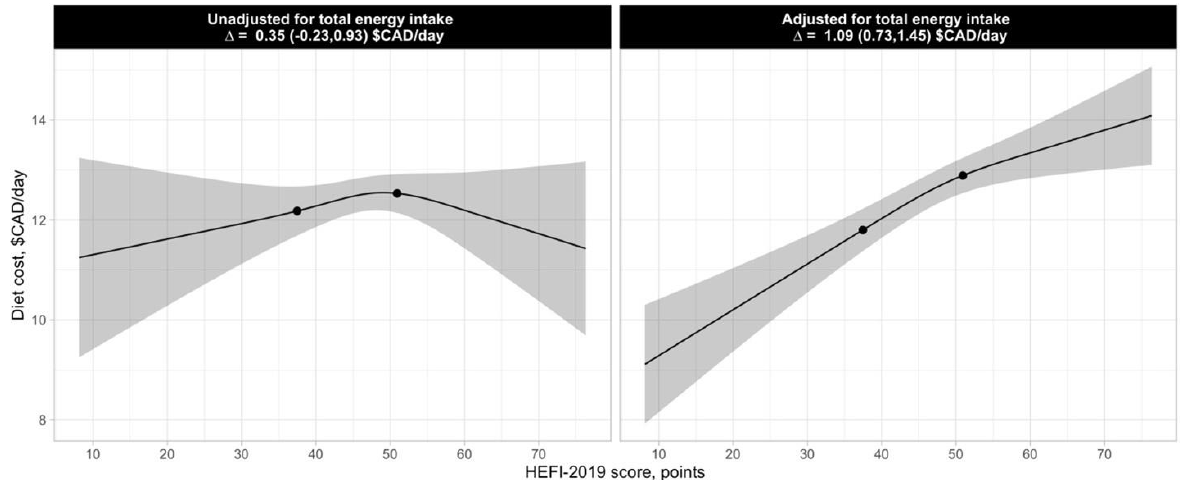
Figure 1. Linear regression of HEFI-2019 scores and estimated daily diet costs in 1147 French-speaking adults from Quebec. A higher HEFI-2019 score indicates a greater adherence to recommendations on healthy food choices in the 2019 CFG. The 25th and 75th percentiles of the HEFI-2019 score distribution are represented by the black dots on the regression line. The estimates presented correspond to the daily diet cost difference between the 75th and 25th percentiles of the HEFI-2019 score distribution. The 95%CI of the regression is represented by the shaded area. The left panel presents the linear regression unadjusted for total energy intake, while the right panel presents the linear regression adjusted for total energy intake. Estimated diet costs and dietary intake data were obtained using the National Cancer Institute’s multivariate method and reflect usual (i.e., long-term) intakes and costs; 95%CI was estimated using 200 bootstrap resamples. CAD, Canadian dollars; HEFI-2019, Healthy Eating Food Index-2019.